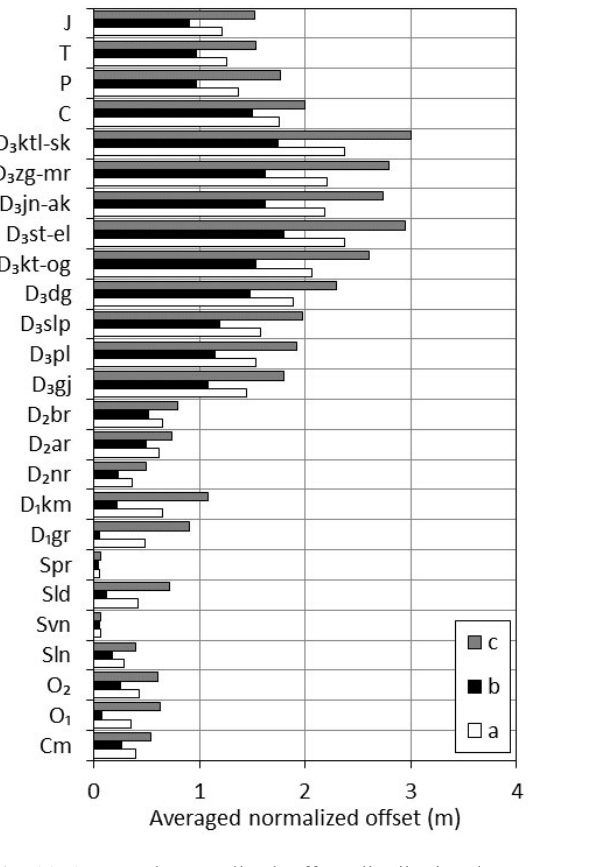
Fig. 11. Averaged normalized offset distribution between the modelled surfaces and borehole data: a, all boreholes; b, boreholes with full thicknesses; c, boreholes which reach only the surface of a particular